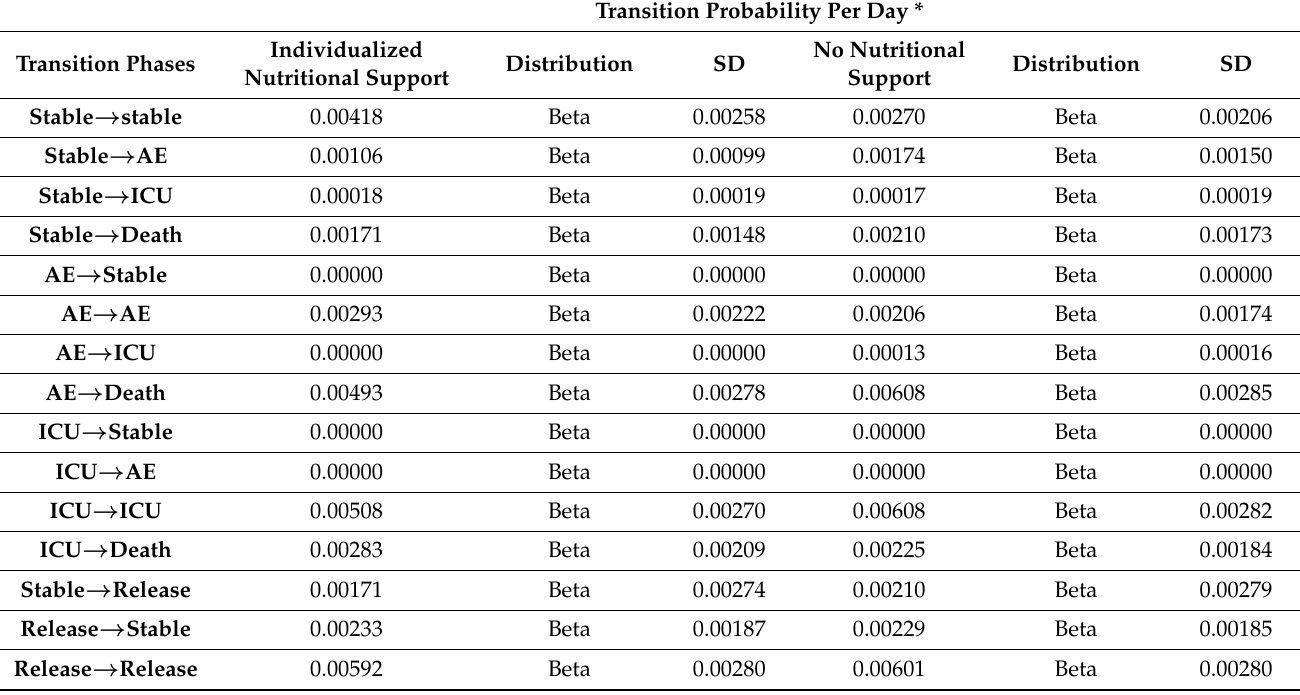
Table A2. Transition probabilities for the health states in the model.